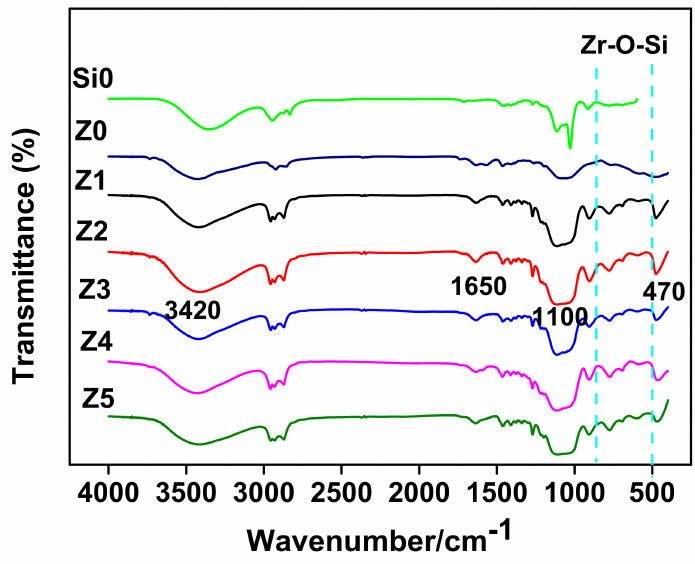
Figure 3. Infrared spectrum of Z1, Z2, Z3, Z4, and Z5 composite